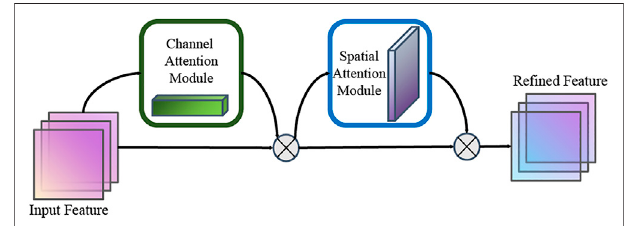
FIGURE 2 | Overview of CBAM. The module has two sequential submodules: channel and spatial (Woo et al., 2018).